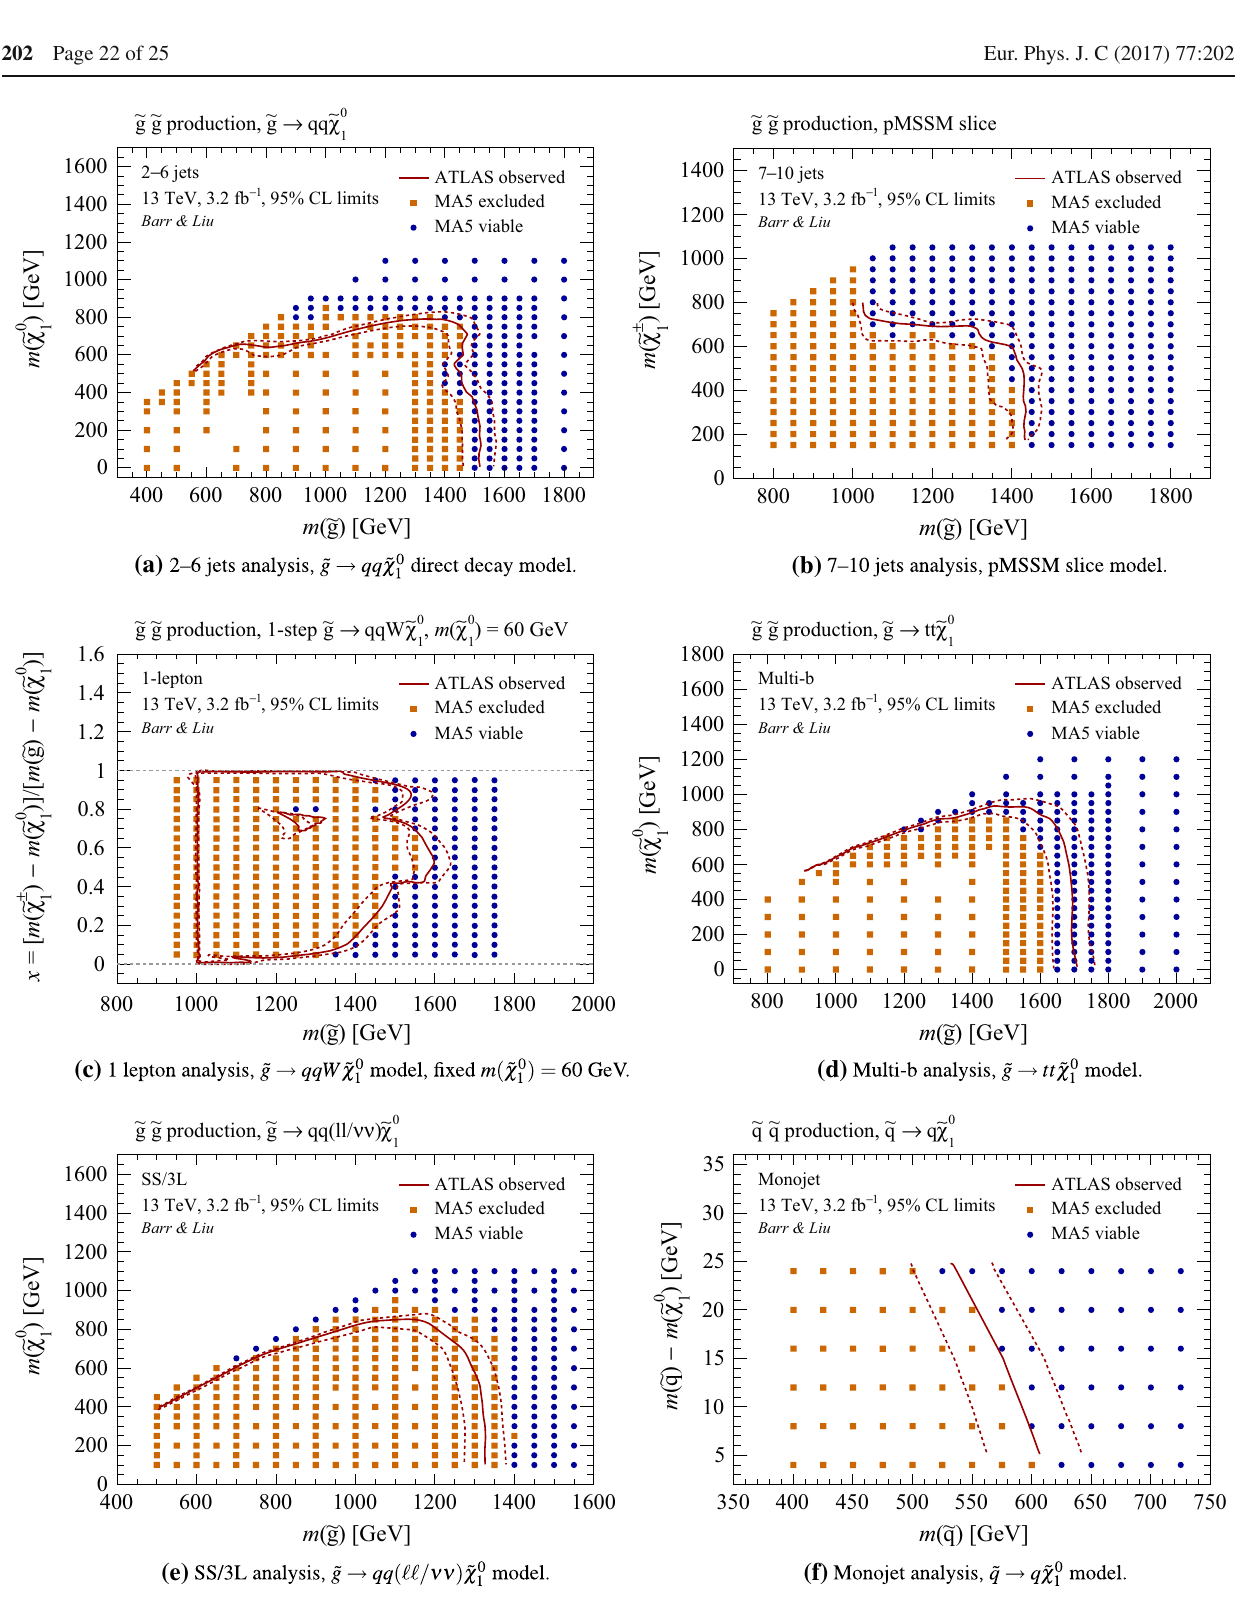
uncertainties. Orange squares indicate points generated by us excluded at 95% confidence level ‘MA5 excluded’, while blue circles are those not excluded ‘MA5 viable’. The models follow the nomenclature used by ATLAS for ease of comparison; see the references in Table 1 for